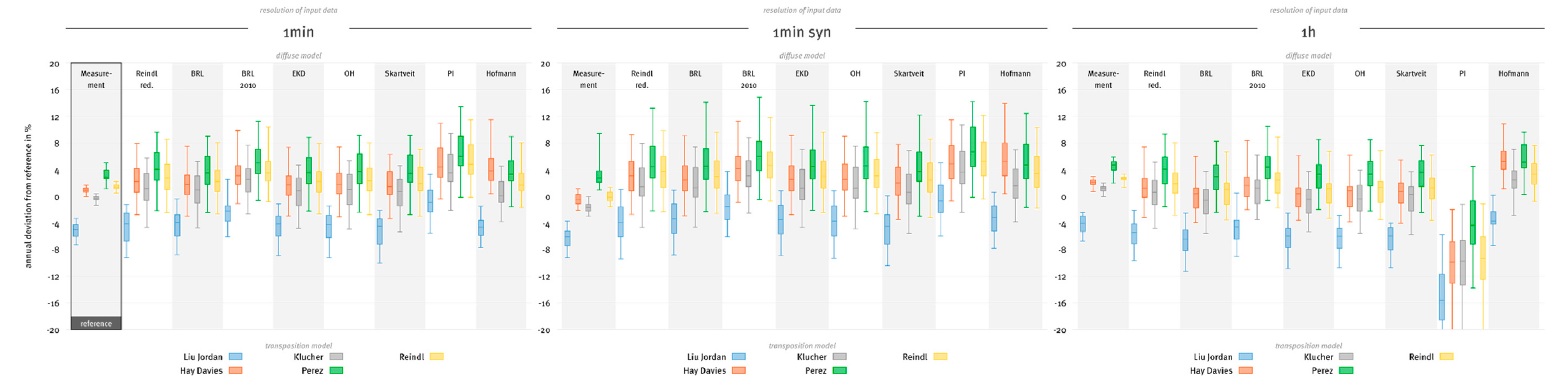
Figure A3. Same plot type as Figure A1, but for modules with two-axis tracking. Note the different y scale in comparison to Figures A1 and A2.